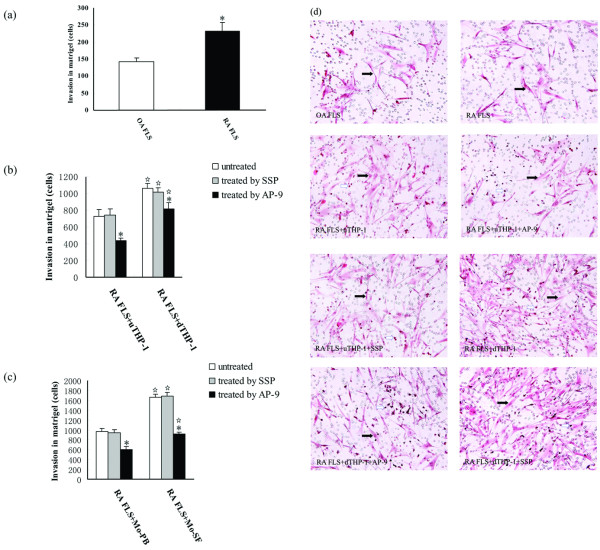
Invasive potential in co-culture of rheumatoid arthritis (RA) fibroblast-like synoviocytes (FLS) and monocytes/macrophages or THP-1 cells, and RA/osteoarthritis (OA) FLS alone. The invasive potential was evaluated in transwell chambers as described in Patients and methods. Briefly, cells were suspended in serum-free media supplemented with or without AP-9 or SSP (200 μg/ml) and seeded into the upper side of the matrigel (5 μg/ml)-coated chambers. After incubation for 24 hours at 37°C, the number of invaded cells was determined using a colorimetric H & E assay. Black arrow, FLS; white arrow, THP-1 cells (f × 200). (a) and (d) The invasive potential of RA FLS was higher than that of OA FLS (P < 0.05; six samples with RA FLS, four samples with OA FLS). (b) and (d) the invasive potential of RA FLS co-cultured with undifferentiated THP-1 cells (uTHP-1) and differentiated THP-1 cells (dTHP-1) and the invasive potential of co-cultured cells inhibited by AP-9 (P < 0.05, RA FLS+ uTHP-1 vs RA FLS+ uTHP-1+ AP-9 and RA FLS+ dTHP-1 vs RA FLS+ dTHP-1+ AP-9; n = 6, respectively), while no inhibitory effects were found in irrelevant peptide SSP (P > 0.05, RA FLS+ uTHP-1 vs RA FLS+ uTHP-1+ SSP and RA FLS+ dTHP-1 vs RA FLS+ dTHP-1+ SSP; n = 6, respectively). (c) The invasive potential of RA FLS co-cultured with monocytes/macrophages from synovial fluid of RA patients (Mo-SF) and monocytes from peripheral blood of healthy humans (Mo-PB) and the invasive potential of co-cultured cells inhibited by AP-9 (n = 10, P < 0.05), while no inhibitory effects were found in irrelevant peptide SSP (n = 10, P > 0.05). Values are the means ± standard error (n = 4–10). *indicates P < 0.05 (experimental groups versus control groups). Stars indicate P < 0.05 (RA FLS co-cultured with dTHP-1 versus RA FLS co-cultured with uTHP-1, and RA FLS co-cultured with Mo-SF versus RA FLS co-cultured with Mo-PB).